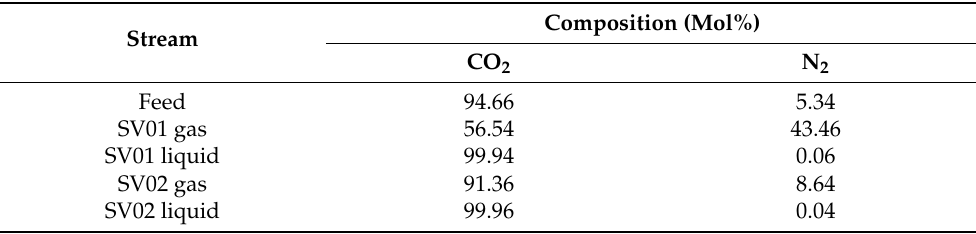
Table 9. Composition of the feed and the gas and liquid outlet of SV01 and SV02 as measured with the GC in Experiment